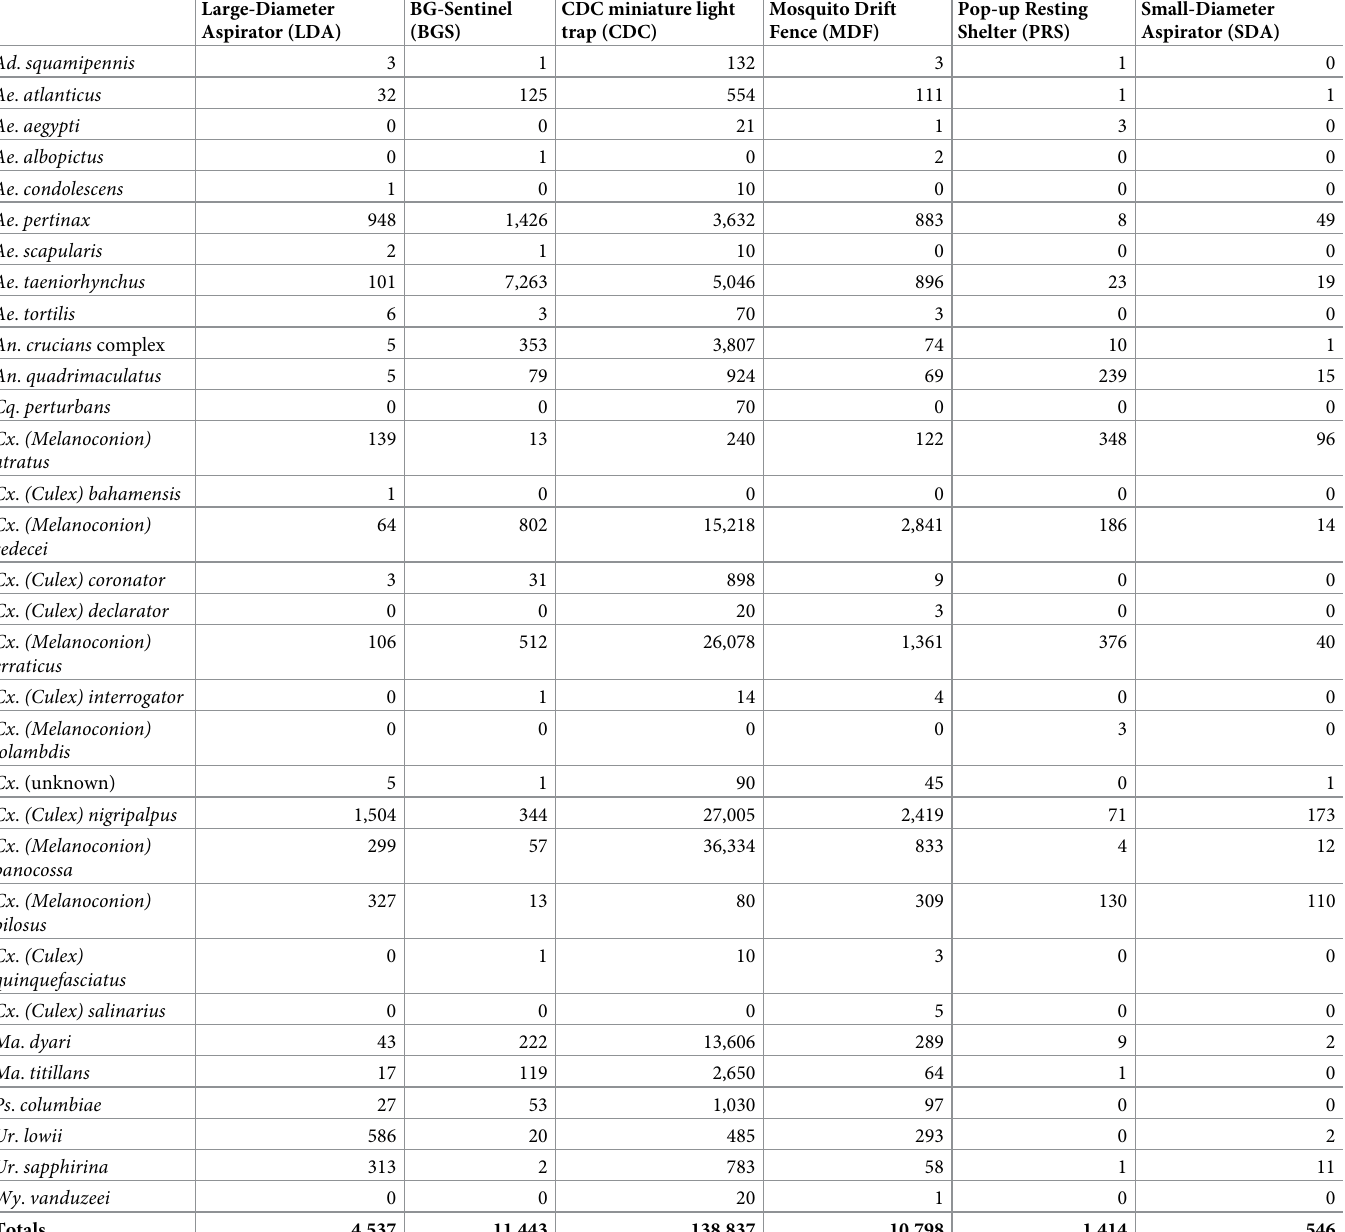
Table 1. Number of each mosquito species captured for the large diameter aspirator (LDA), BG-Sentinel (BGS), CDC miniature light trap (CDC), mosquito drift fence (MDF), pop-up resting shelter (PRS), and the small diameter aspirator (SDA) in Florida City, Florida. Large-Diameter Aspirator